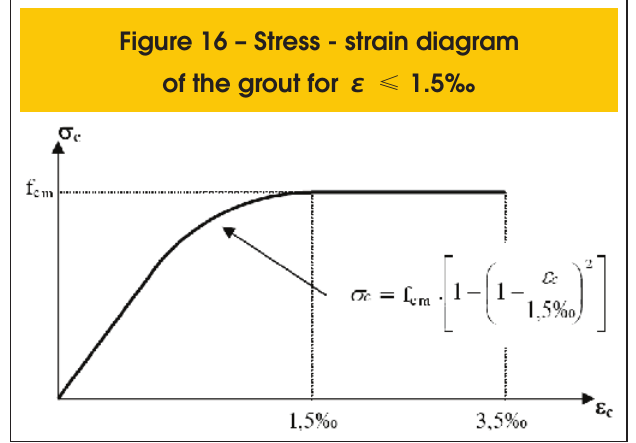
Figure 16 – Stress - strain diagram of the grout for ε ≤